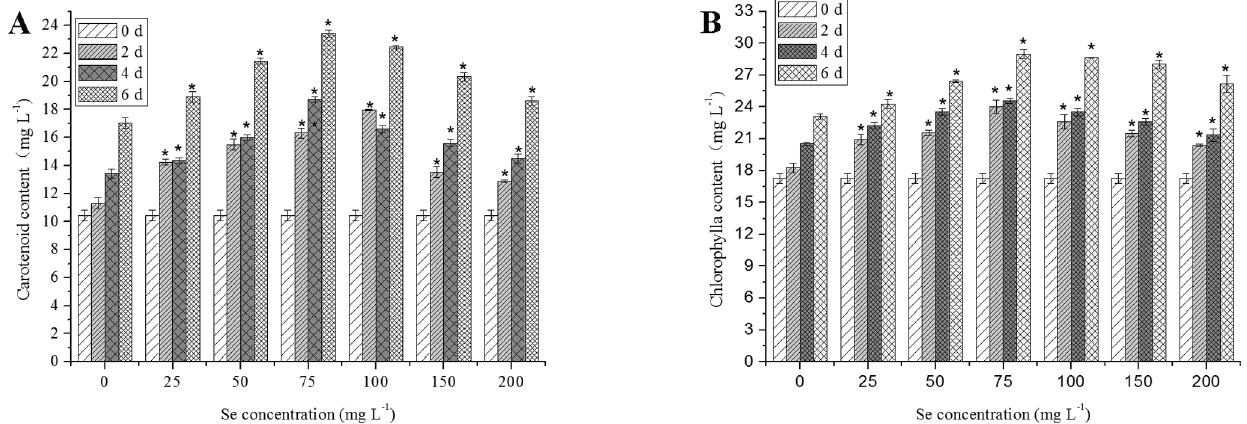
Figure 3. Changes in photosynthetic pigments of C. vulgaris during cultivation time of day 0, 2, 4 and 6 at different Se concentrations. (A) Carotenoids (including lutein and b -carotene). (B) Chlorophyll a. The single asterisk * in the figure represents significant difference compared to control ( P , 0.05). Values expressed are means 6 SD of three replicates.